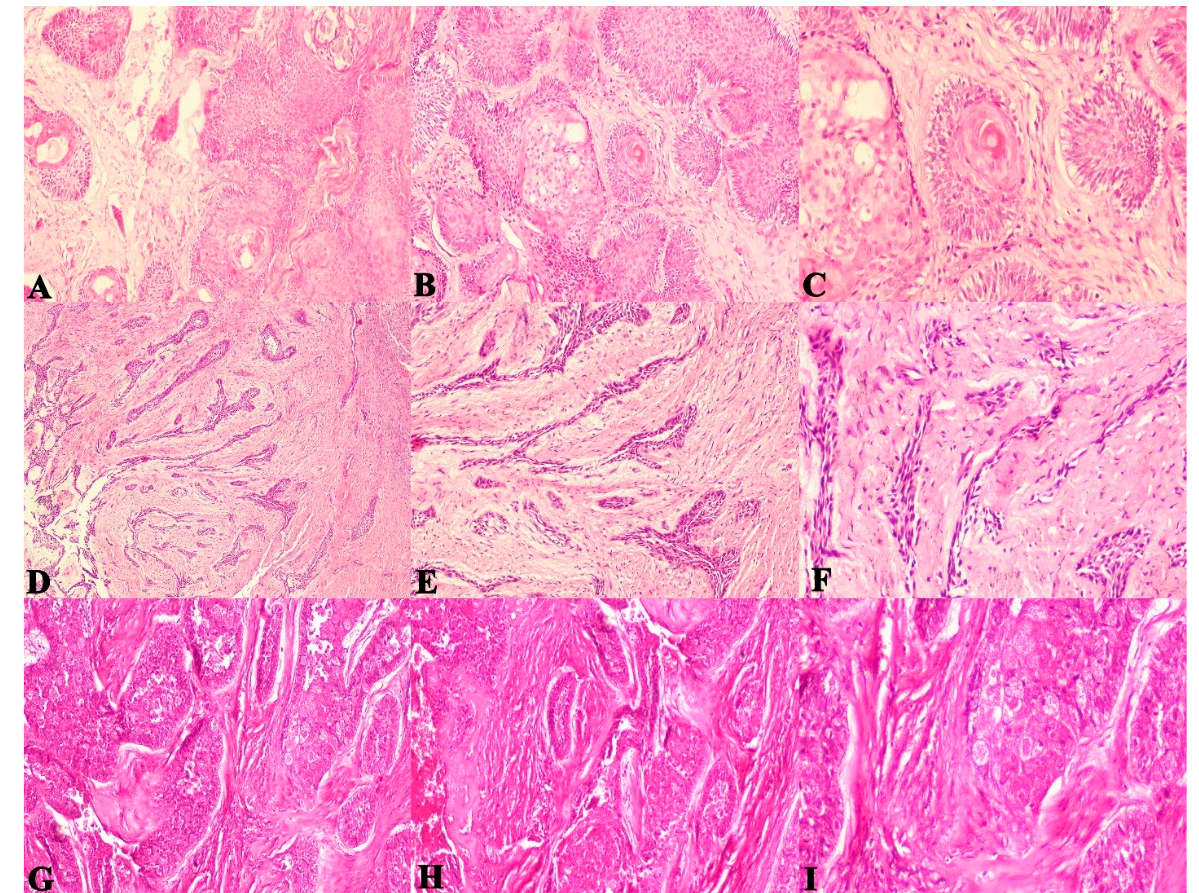
Figure 6. Photomicrographs of haematoxylin and eosin stain. Acanthomatous ameloblastoma exhibiting extensive hyalinization between follicles, ( A ). 40×, ( B ). 100× and ( C ). 400× Desmoplastic ameloblastoma exhibiting thin compressed strands due to desmoplastic changes and hyalinization, ( D ). 40×, ( E ). 100× and ( F ). 400× Granular cell ameloblastoma exhibiting extensive hyalinization between follicles filled with large granular cells, ( G ). 40×, ( H ). 100× and ( I ). 400×.